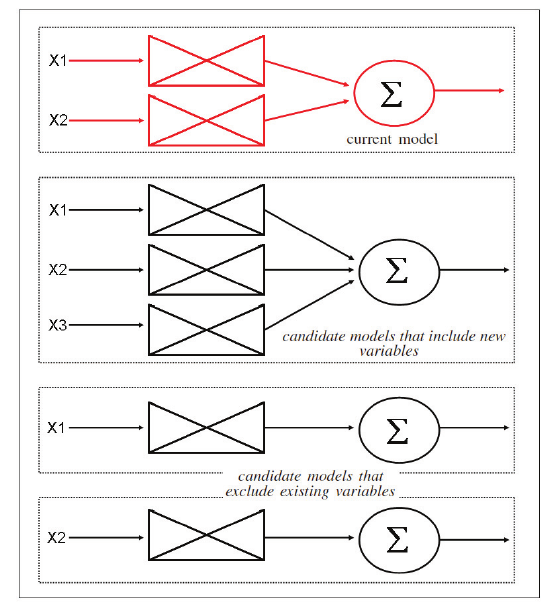
Figure 2. Candidate